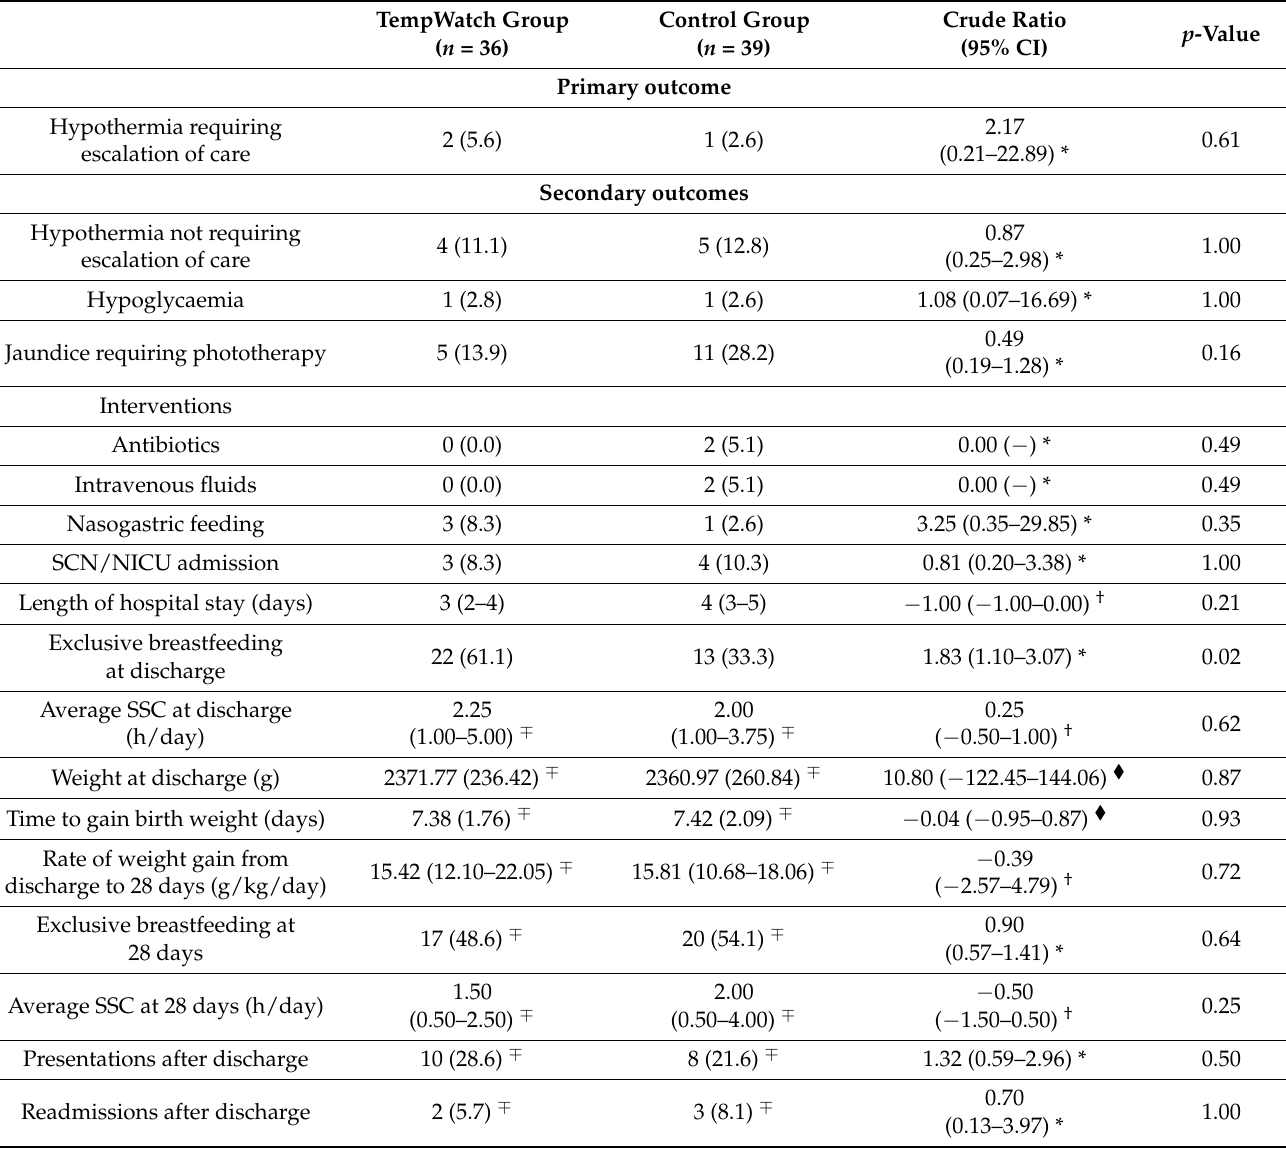
Table 2. Primary and secondary